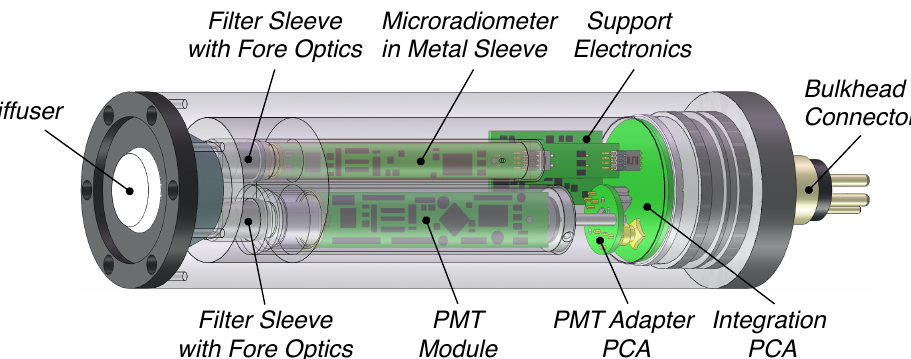
Figure 6. Paired PMT and microradiometer detector technologies in a irradiance sensor dyad (PAR or fixed wavelength) with a 2.0in (5.1cm) housing diameter that is 9.5in (24.1cm) long, and a total weight of 1.8lb (0.8kg). The nominal depth rating is 2000m, although variations of the design with a greater depth capability are easily fabricated.